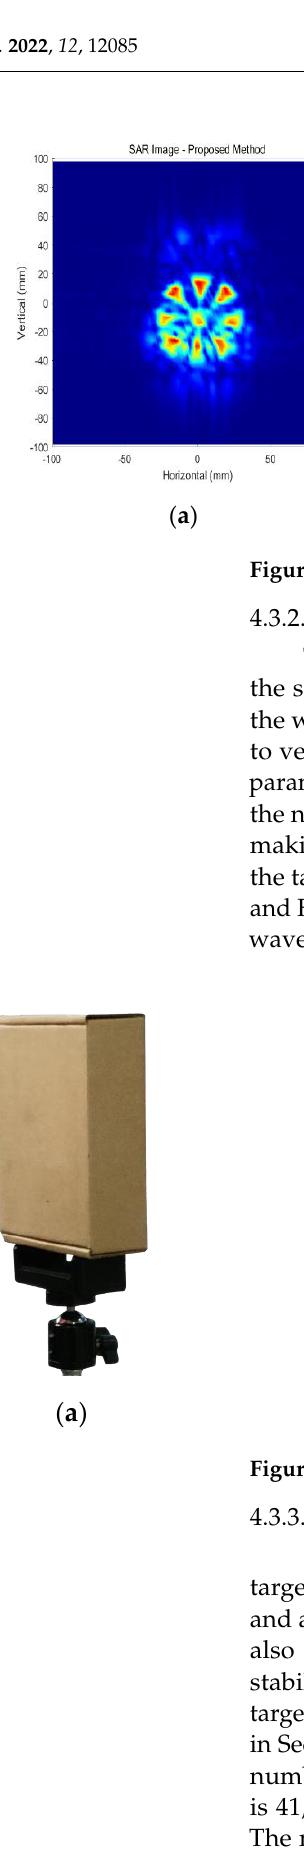
Figure 7. Horizontal direction and vertical direction sparsely-sampled: ( a ) mmSight; ( b ) Back Pro- jection; ( c ) Matched Filter.